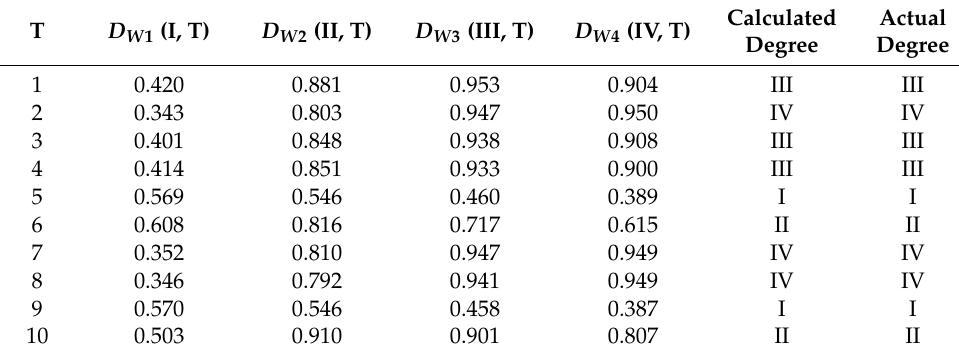
Table 10. The calculated stability grades for the slopes of group B using weight vectors determined by eight